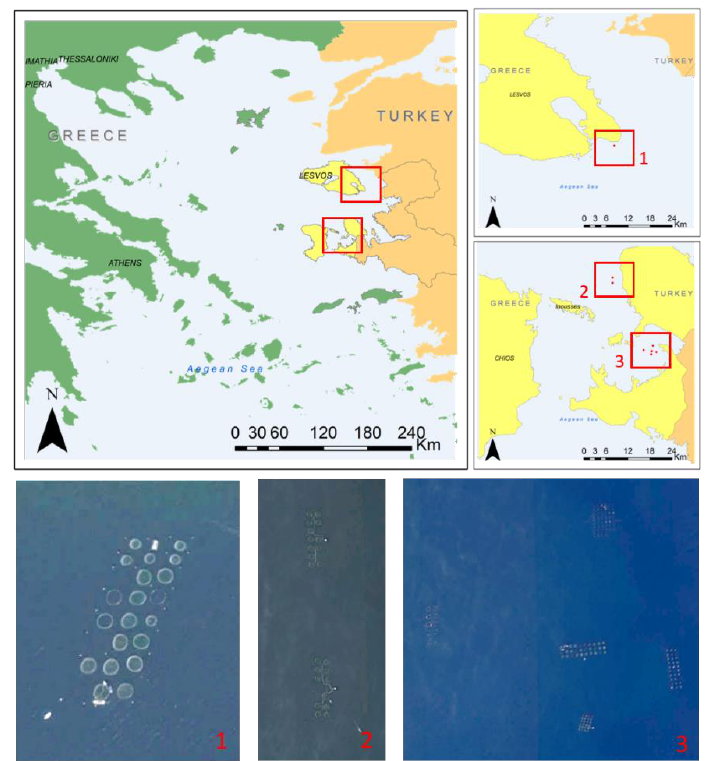
Figure 2. The study sites are located in north Aegean Sea, near the coastline of the Greek Lesvos Island (up) in Kratigos (1) and the Turkish ˙Izmir Province (down) near Karaburun Peninsula (2) and Ildir Bay (3). Satellite images from Google Earth show the farms in more detail. In photo 2, the feeding system used in the farms is